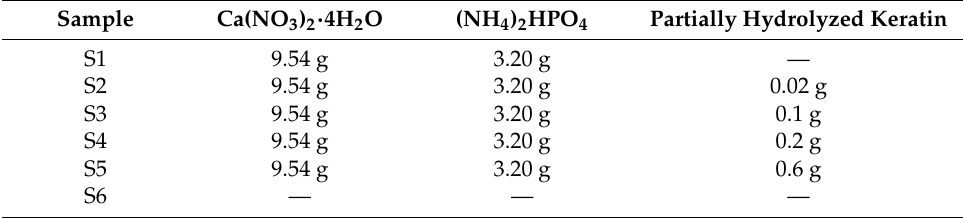
Table 1. The formulae of synthesized HA samples (S1–S5) and HA derived from scales set as S6.